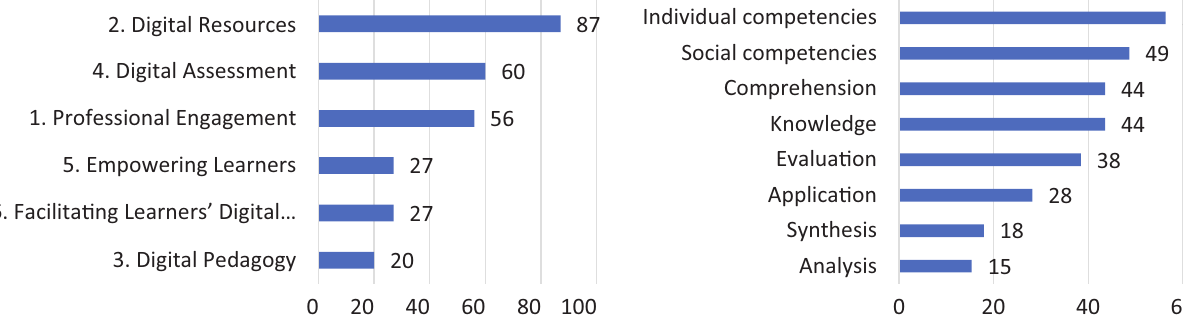
Figure 6. Comparison of the results based on the digital competence in education model and Bloom’s